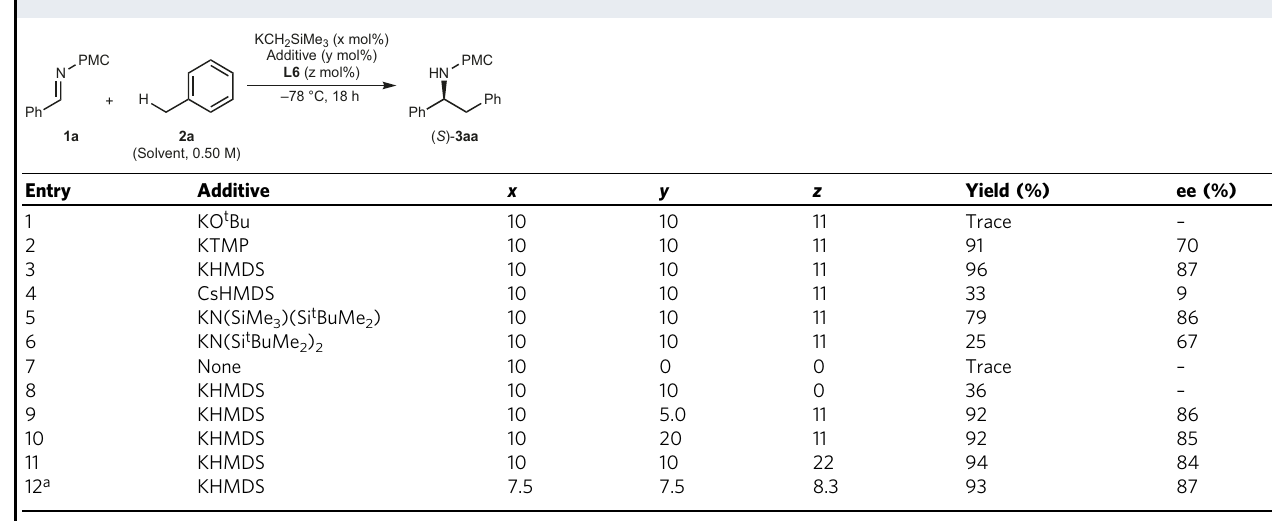
Table 2 Effect of